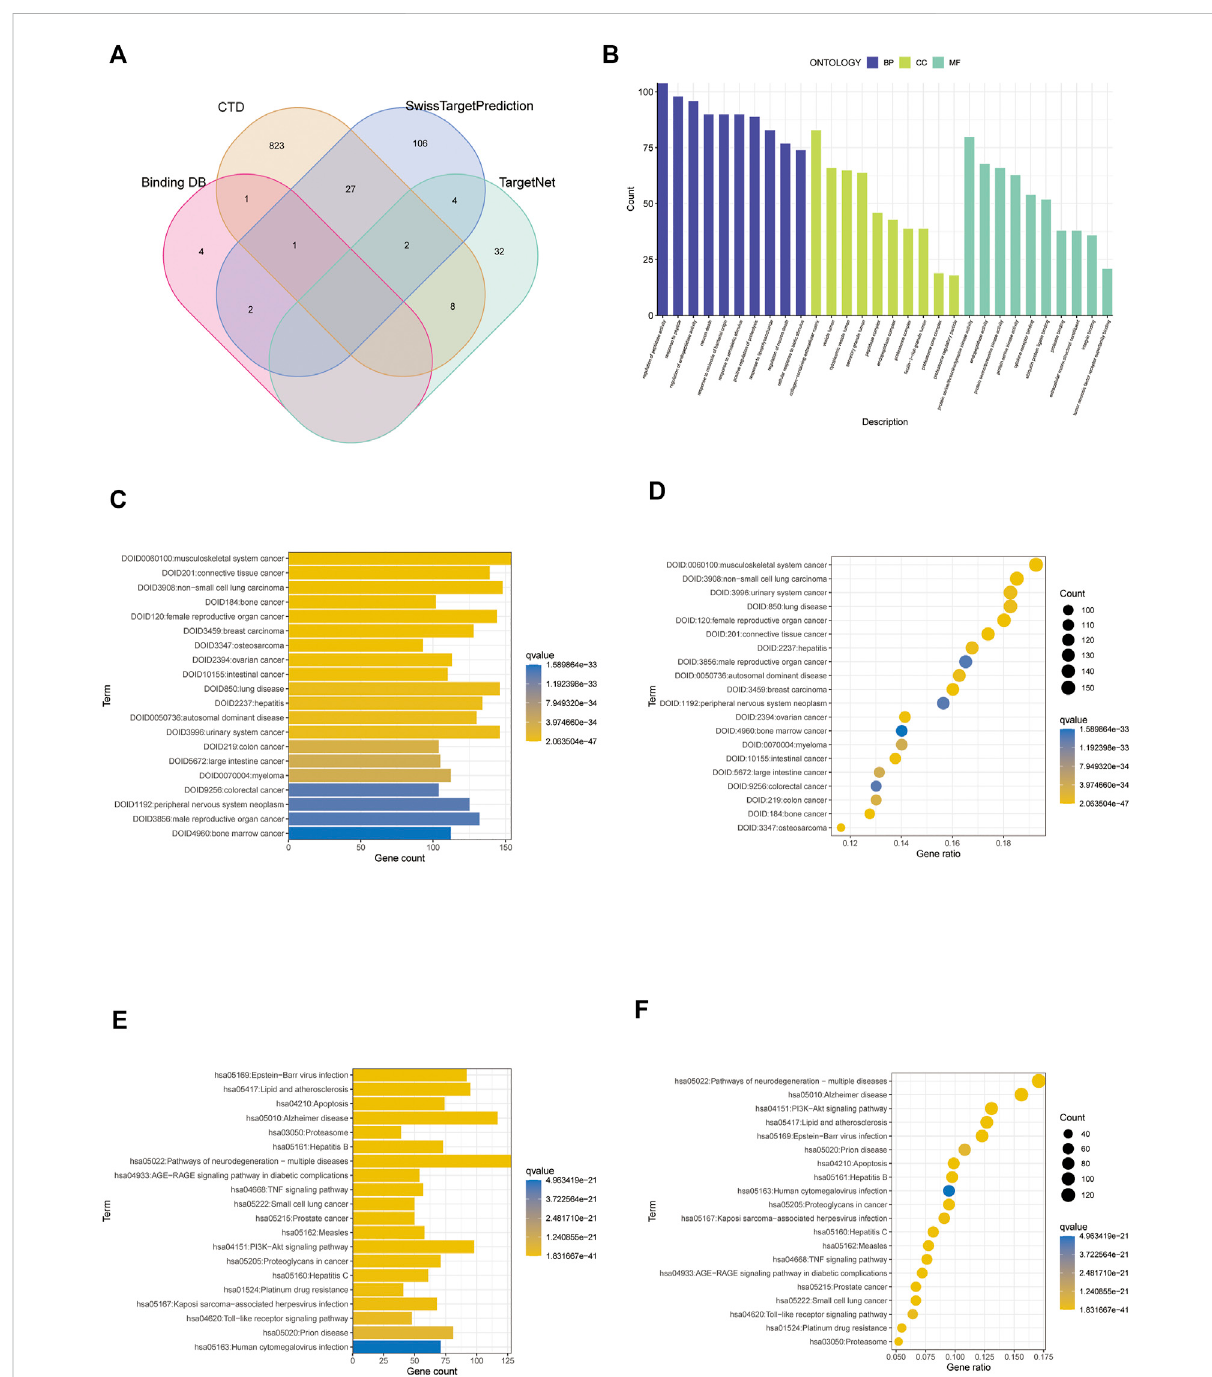
FIGURE 2 Screening analysis of paclitaxel targets. (A) Venn diagram of paclitaxel in the four databases. (B) Gene Ontology (GO) enrichment analysis of paclitaxeltargets. (C,D) DOenrichmentanalysisofpaclitaxeltargets. (E,F) KyotoEncyclopediaofGenesandGenomes(KEGG)enrichmentanalysisof paclitaxel